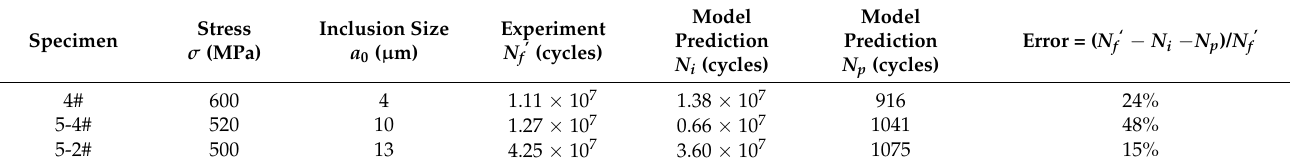
Table 6. Comparison of the very high cycle fatigue life estimation model and experimental results. Specimen